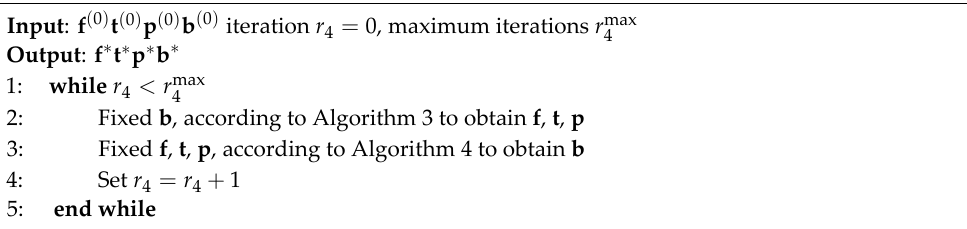
Algorithm 5 : Iterative Algorithm for Communication and Computing